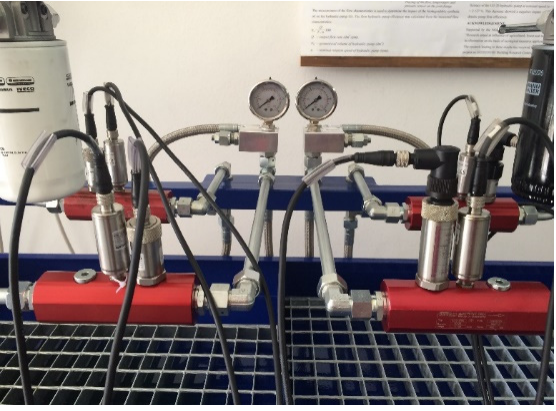
Figure 2. Flow and pressure sensors for an HMG 3010 measuring device.